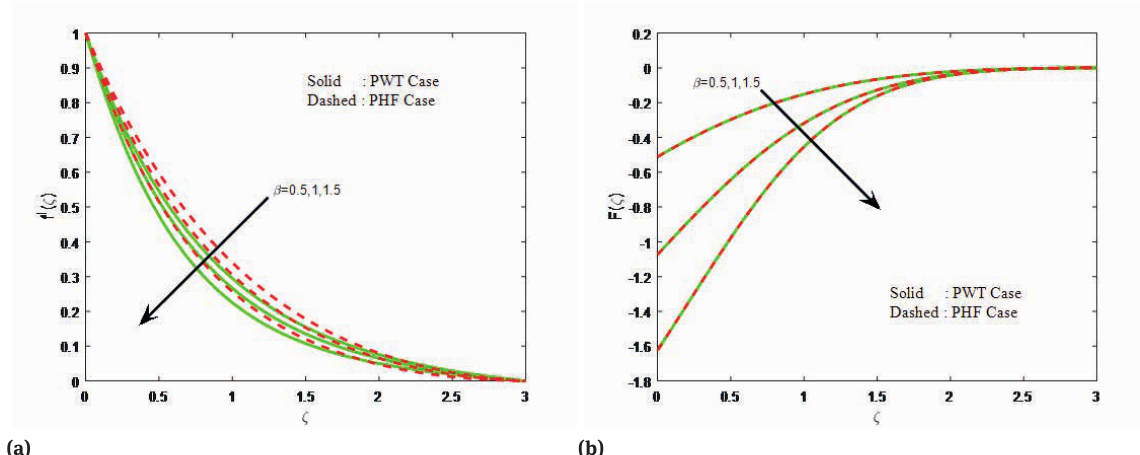
Fig. 2: a,b) Velocity profiles with varying fluid particle interaction parameter β .